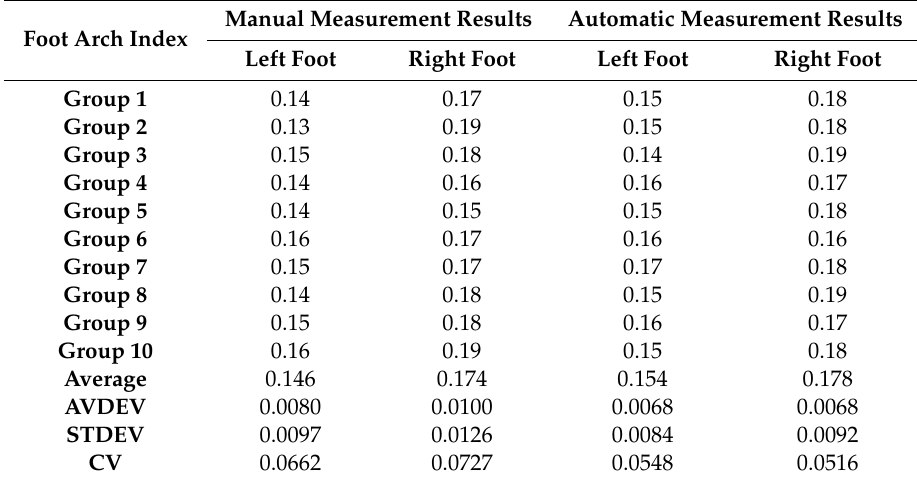
Figure 9. Footprints obtained by manual measurement. ( a ) High arch foot. ( b ) Normal foot. ( c ) Flat foot.